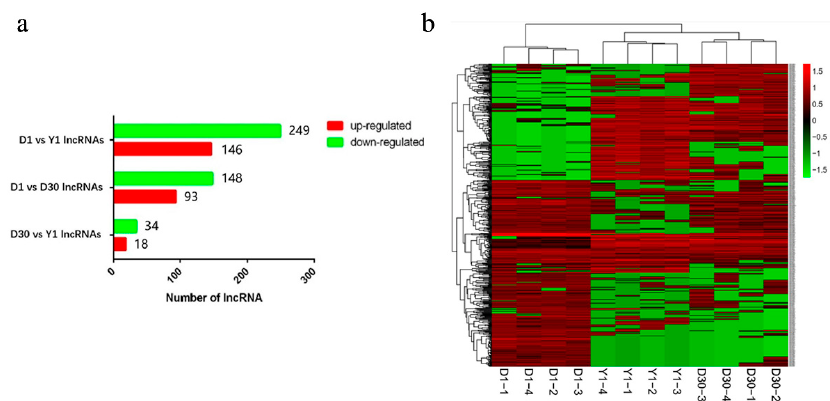
Figure 3. Analyses of differentially expressed lncRNAs from 12 libraries. ( a ) Numbers of upregulated and downregulated lncRNAs in three stages of perirenal fat. ( b) Hierarchical cluster analysis of differently expressed lncRNAs in perirenal fat of goats. The red signal refers to relatively high expression, and the green signal refers to relatively low expression.